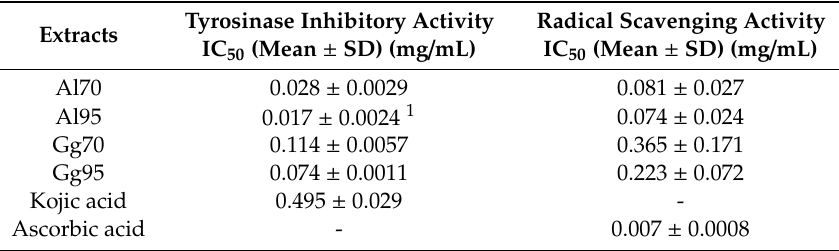
Table 1. Total phenolic and flavonoid content, antioxidant activity, and mushroom tyrosinase inhibitory activity of A. lakoocha (Al) and G. glabra